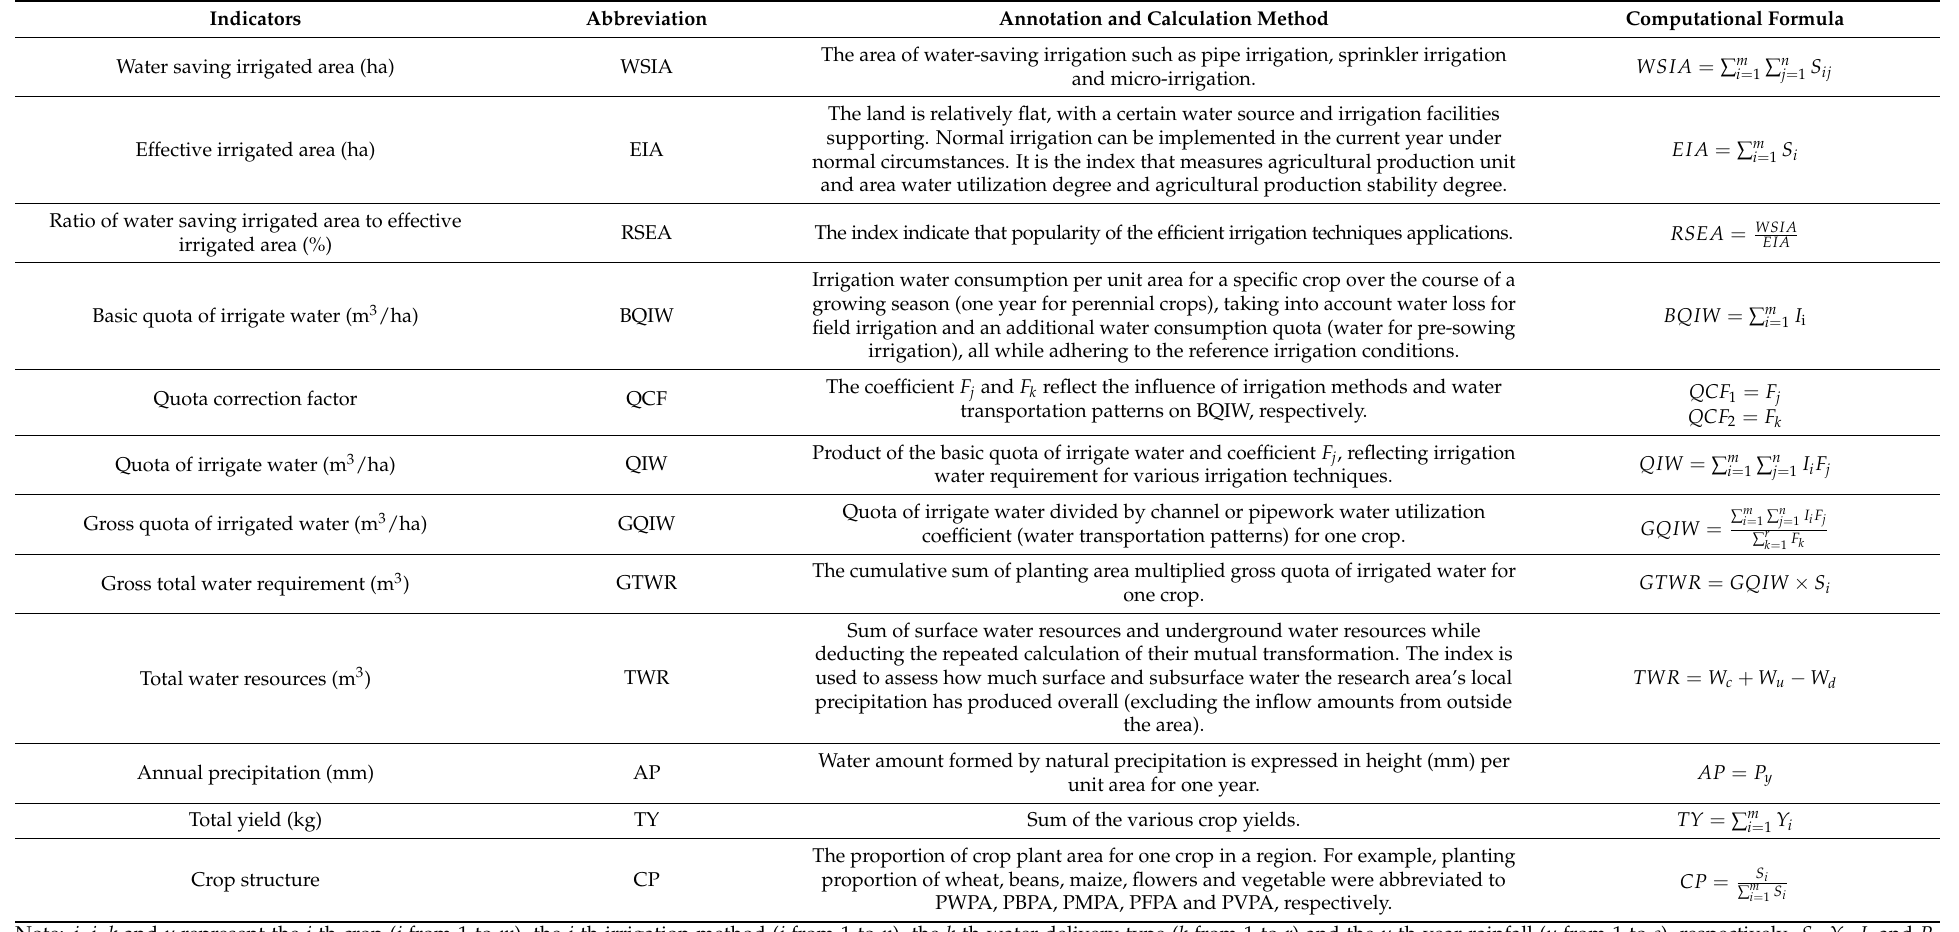
Table 1. Selected irrigation project metrics for optimizing crop